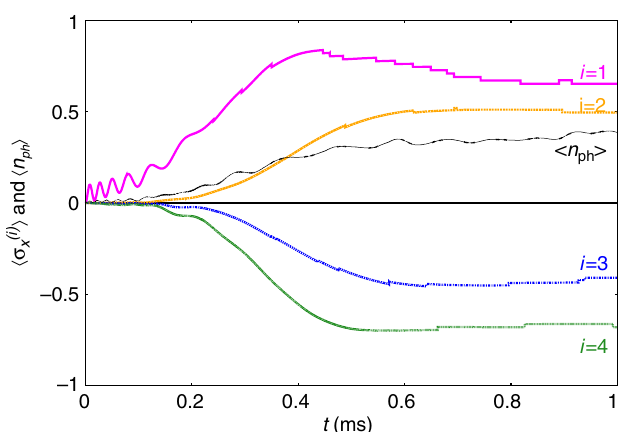
Figure 5 | Simulated quantum annealing in the open system. Using a Monte Carlo wave-function description averaged over 100 runs, we simulate the annealing process with N ¼ 4 ions in the presence of dephasing and spontaneous emission. With a noise rate G ¼ 0.03 J rms E 120Hz and a total annealing time T ¼ 1ms, we have on average one jump per run, n jumps ¼ 0 : 96. We plot expectation values of the spins and total number of phonons, produced by the coupling, as a function of time. Here, we have operated in the ferromagnetic regime between the second and third phonon resonance, d ¼ 2 p (cid:2) 159kHz. Choosing O ¼ 2 p (cid:2) 50kHz, o recoil ¼ 2 p (cid:2) 15kHz, o z ¼ 2 p (cid:2) 876kHz, B max ¼ 50 J rms E 200kHz, and with H ¼ H 0 ( t ) þ H B ( t ) þ h bias . To solve this set of 5 N first-order differential equations, we make a semi-classical approximation order Runge–Kutta algorithm. The semi-classical approximation is justified as long as the system remains close to the phonon vacuum. A direct comparison with exact results for six ions (see Fig. shows that the semi-classical approach, while slightly overestimating fidelities, accurately reproduces all relevant time scales. This approach allows us to extend our simulations up to N ¼ 22 ions, at trap frequency o z ¼ 2 p (cid:2) 270 kHz. We operate between the first and second resonance where the level spacing is largest, at a beatnote frequency o L ¼ o 1 þ 0.2( o 2 (cid:3) o 1 ), that is with a fixed relative detuning between the two modes. This choice corresponds to d ¼ 2 p (cid:2) 1.2 MHz in Fig. 3, characterized as a glassy instance of the system.